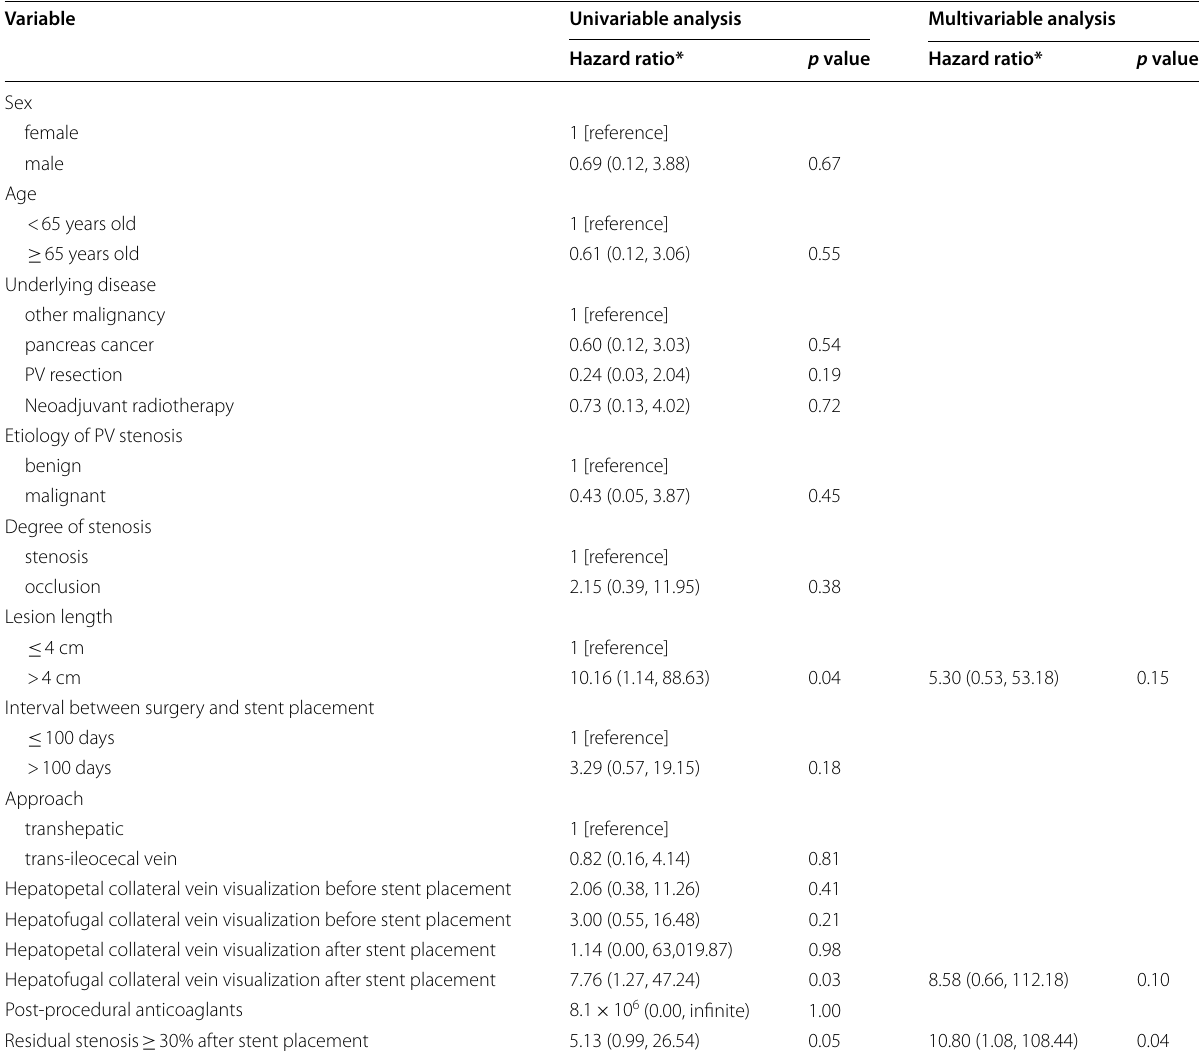
Table 3 Univariable and multivariable Cox regression analysis of risk factors for stent occlusion. (Location: After the sub-heading “Statistical analysis of risk factors for stent occlusion” in the Results)